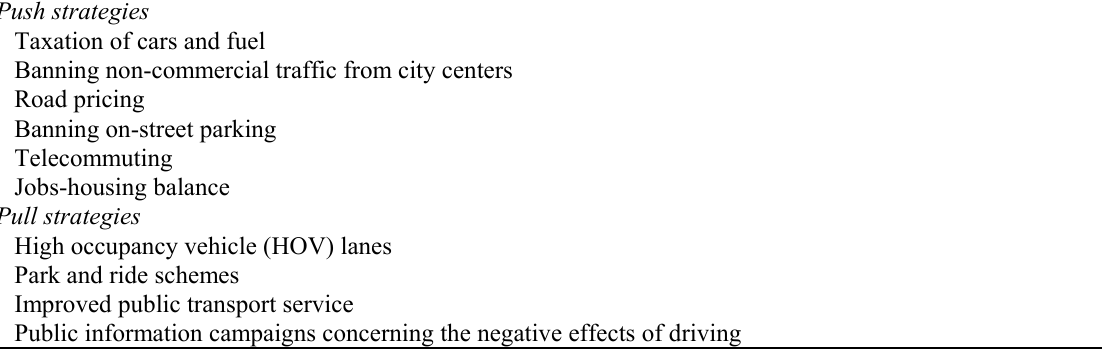
Table 4. TDM strategies classified according to Steg and Vlek’s (1997) push-pull